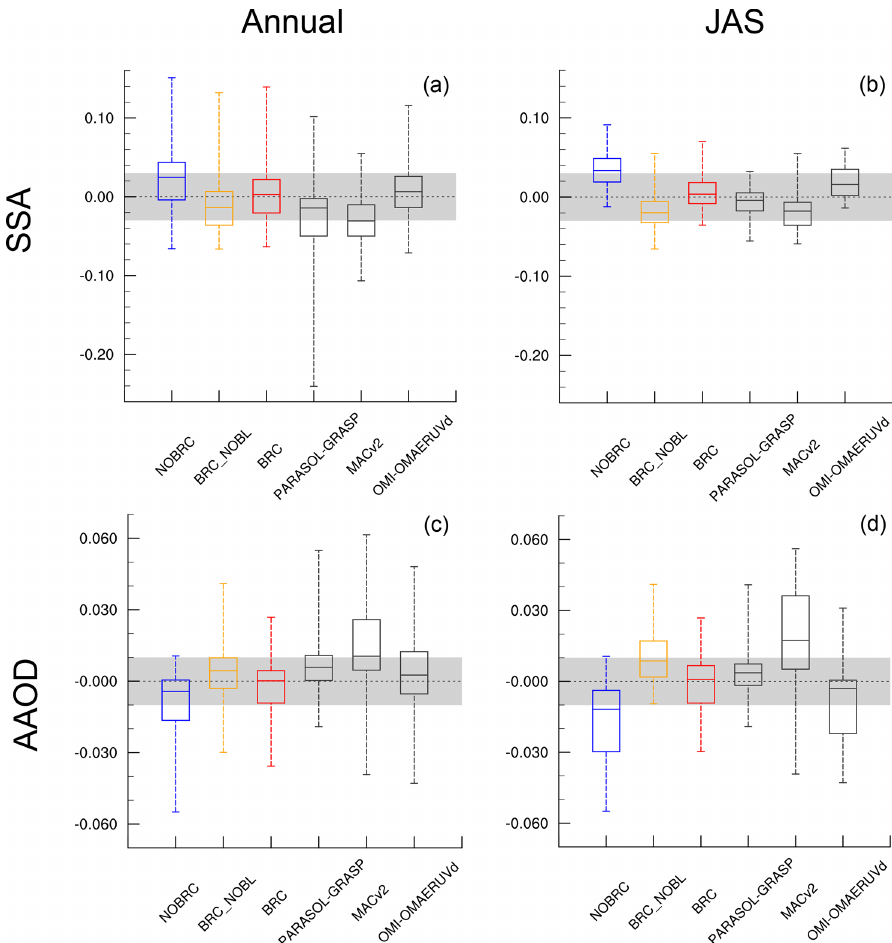
Figure 5. Boxplots of various biases compared to the AERONET observations, over the year (a, c) and over JAS (b, d) . SSA (440nm, a, b ) and AAOD (440nm, c, d ). Simulations: NOBRC, BRC_NOBL, and BRC (see Table 3 for details) and reference data sets (PARASOL- GRASP, OMI-OMAERUVd, MACv2; see Table 2 for details). Uncertainty of the AERONET observations appears